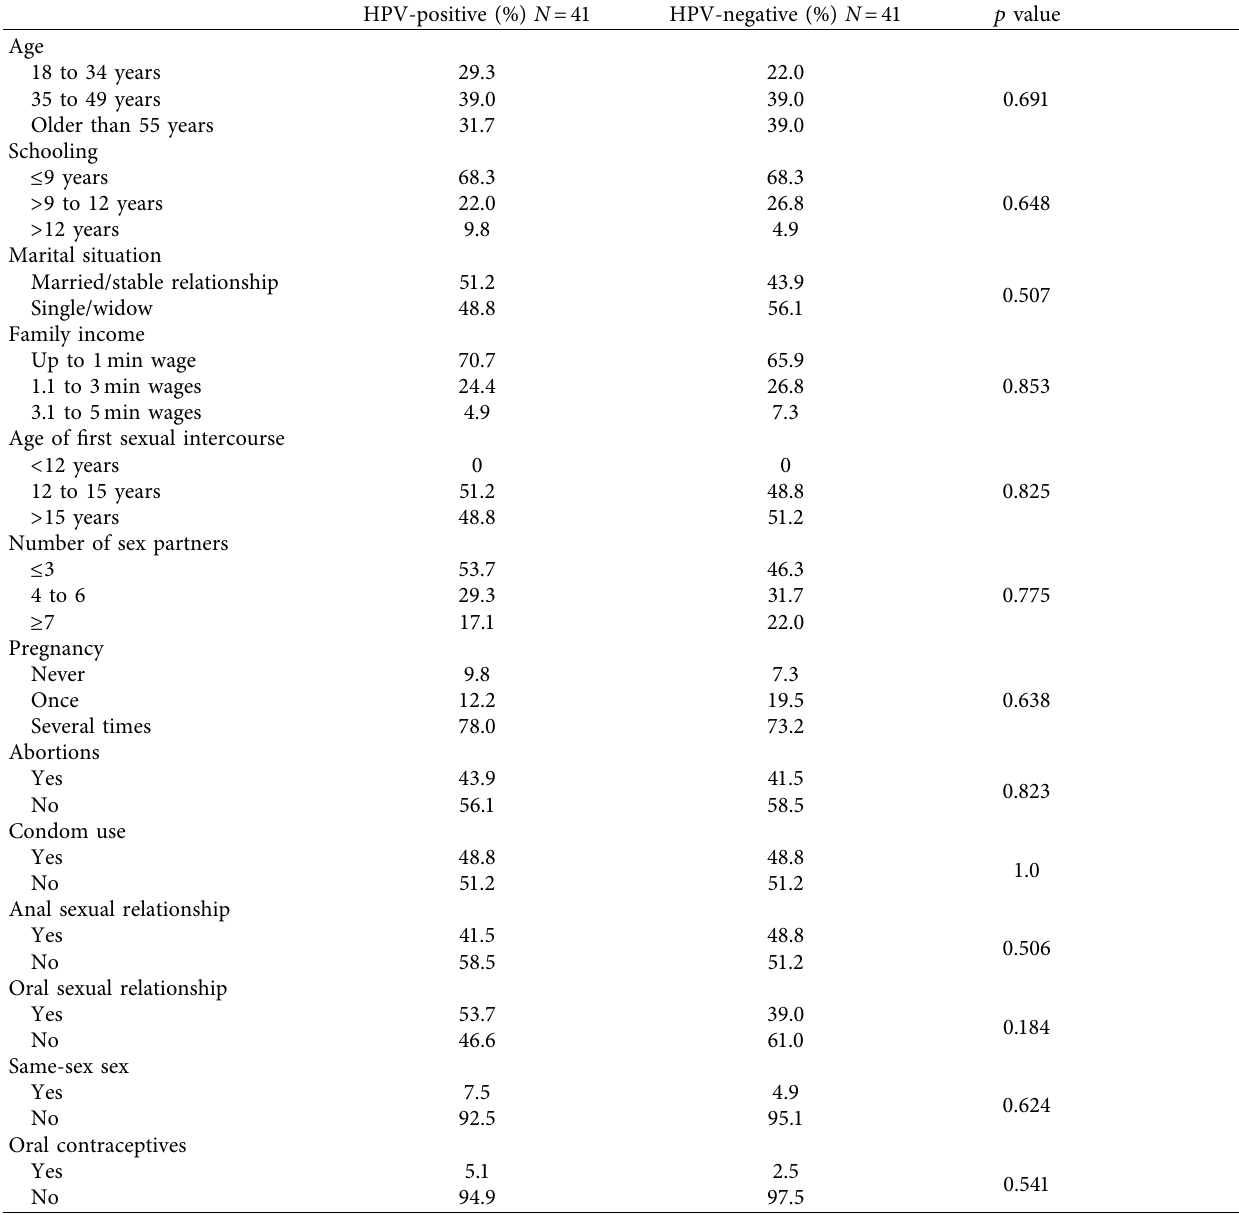
Table 1: Sociodemographic characteristics of HIV-positive women with and without HPV coinfection, São Lu´ıs, Maranhão, Brazil,